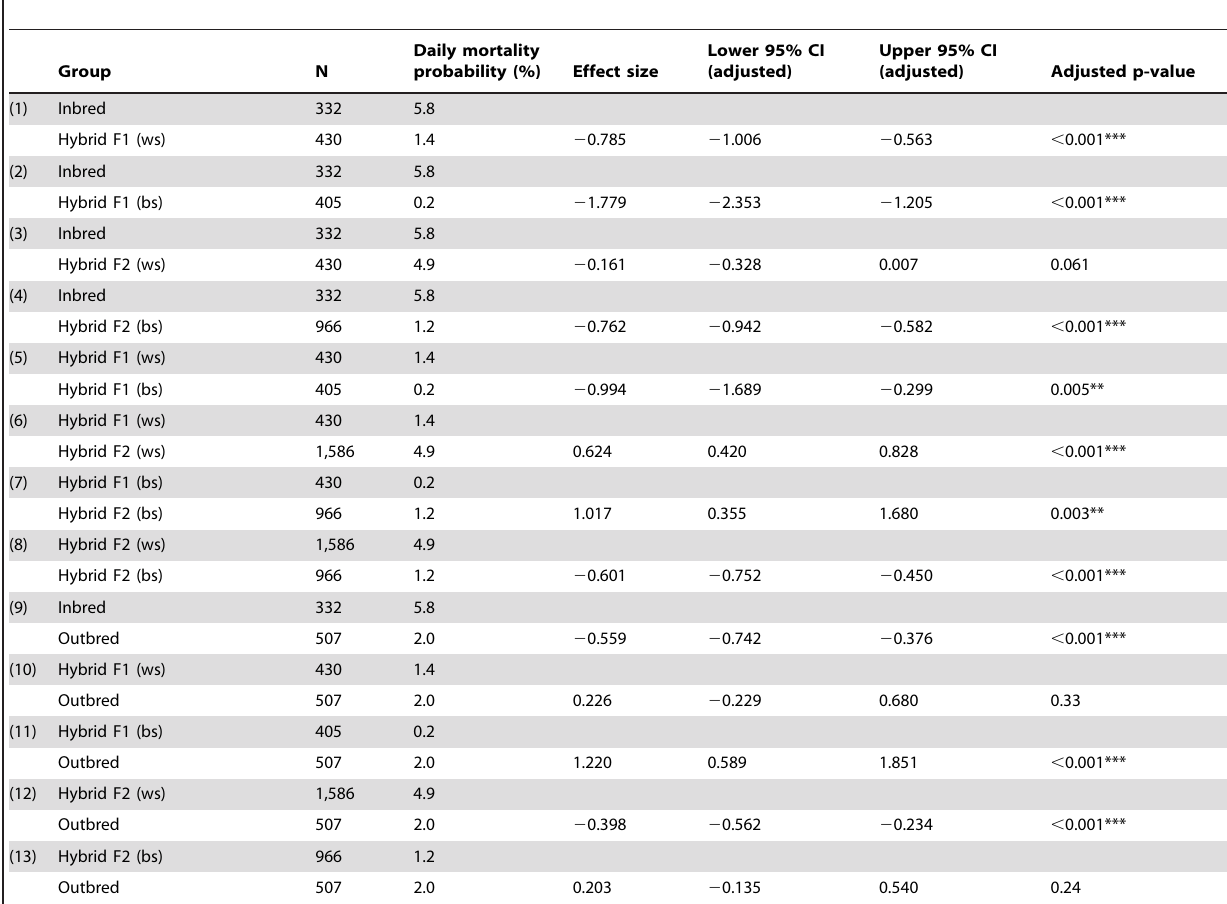
Table 4. Pairwise comparisons of mortality probabilities (as calculated using the Mayfield method), effect size and confidence intervals for the effect size (estimated using the survreg function) of D. melanogaster groups of varying level of inbreeding (ws: within-strain crosses, bs: between-strain